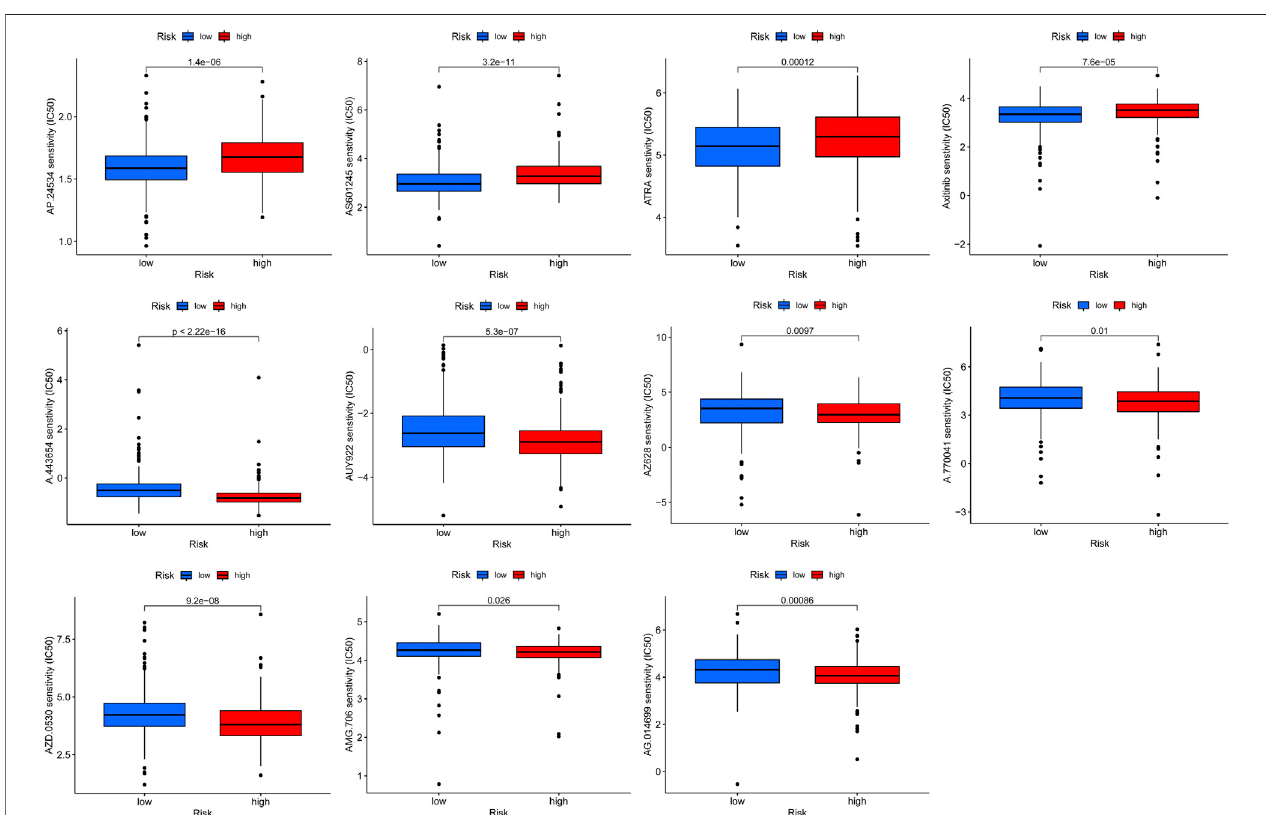
FIGURE 7 | Screening potential drugs by targeting FAM-related lncRNAs